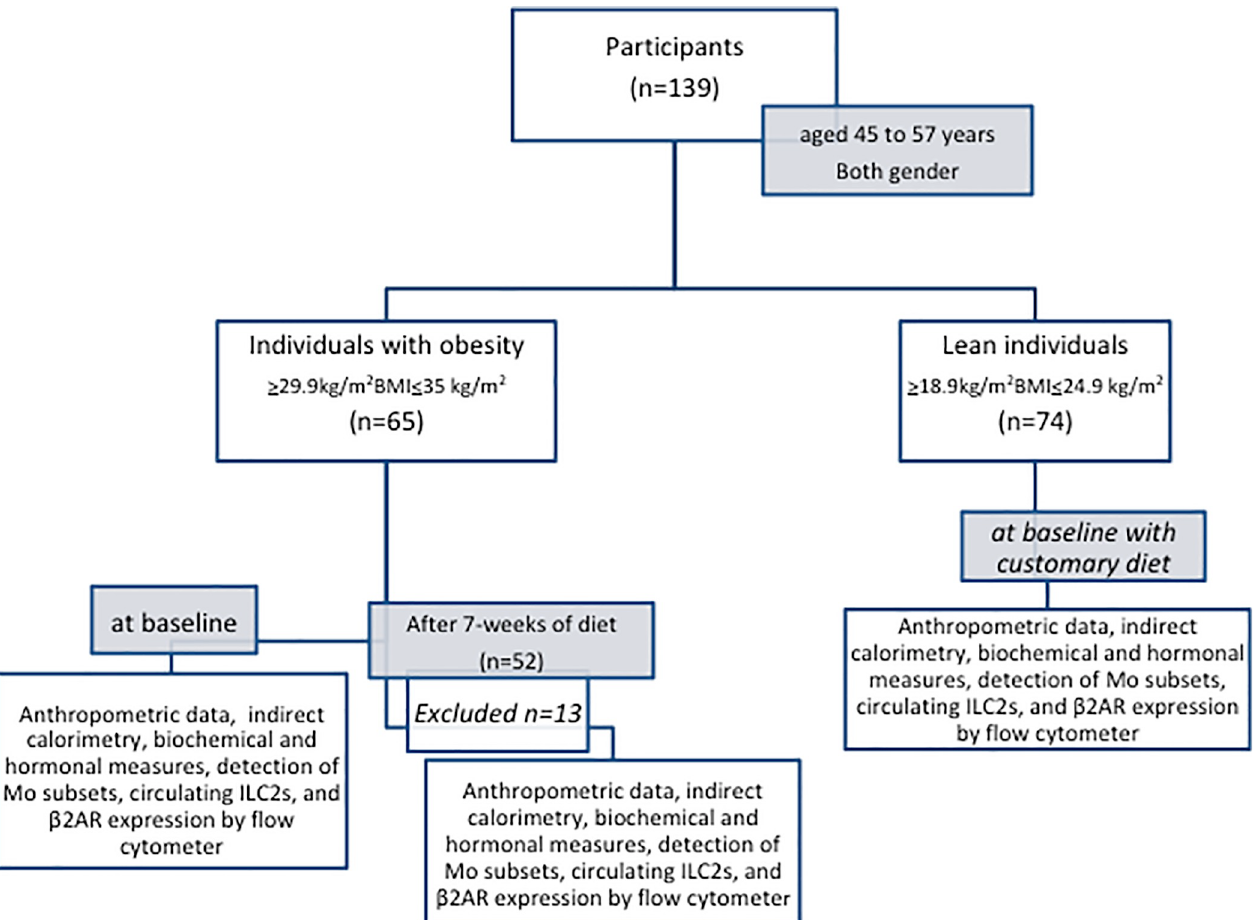
Fig 1. Flow chart for the clinical procedure. Diagram illustrates the sequence of procedures carried out on the study for selection and classification of participants in both groups, assignation of diet in individuals with obesity, and